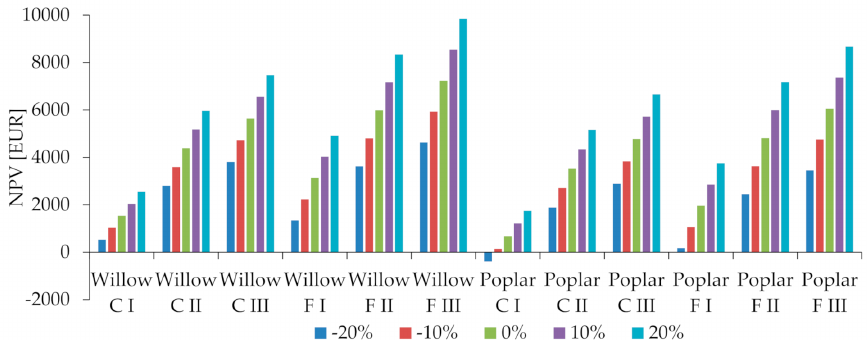
Figure 3. The effect of changes in revenue on the NPV for willow and poplar chip production depending on the soil fertilisation options and payment